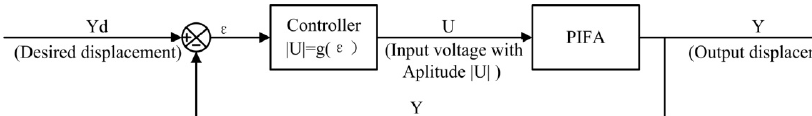
Figure 10. Position feedback control with amplitudes of input voltage.